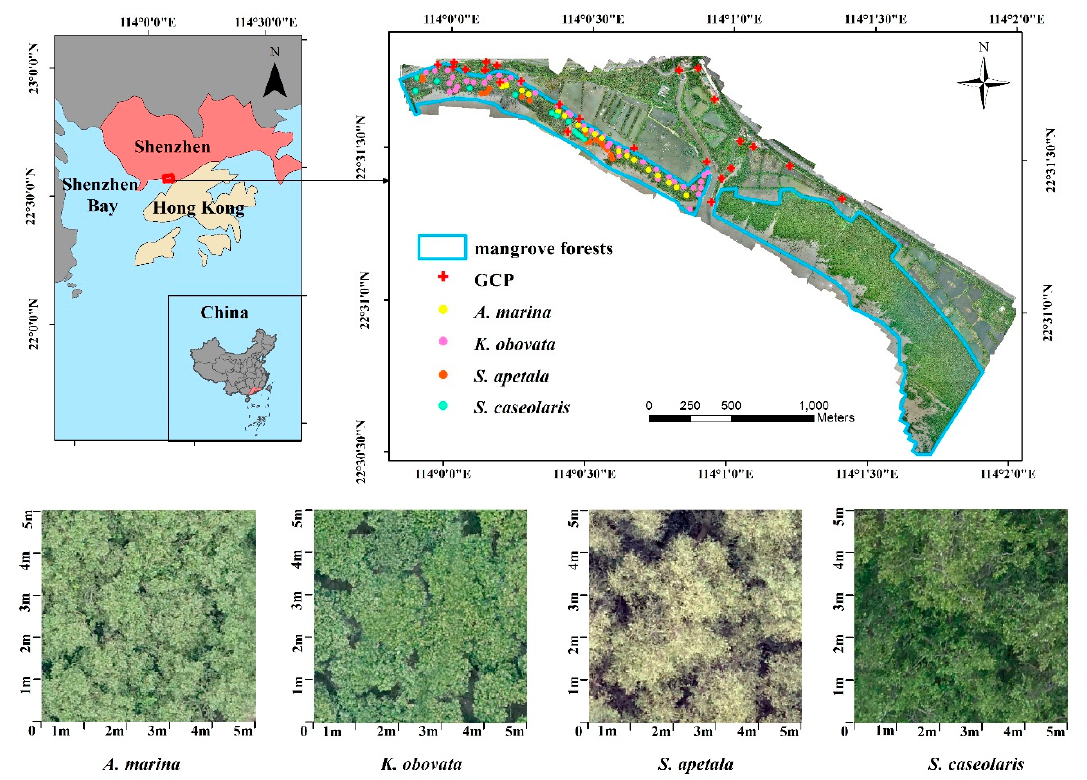
Figure 1. The location of the Futian Mangrove National Nature Reserve and the orthoimage produced from the unmanned aerial vehicles (UAV) flight in the study area with ground control points and field quadrats.